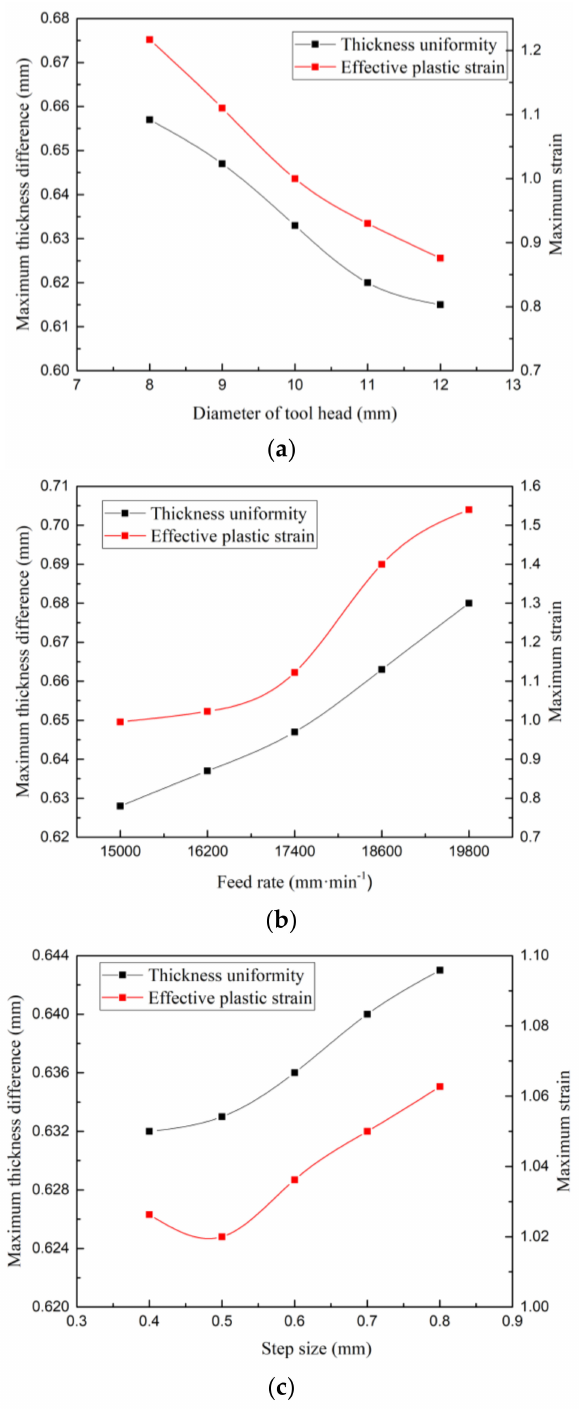
Figure 10. Influence of various process parameters on the maximum thickness di ff erence and maximum strain: ( a ) diameter of the tool head, ( b ) feed rate, and ( c ) step